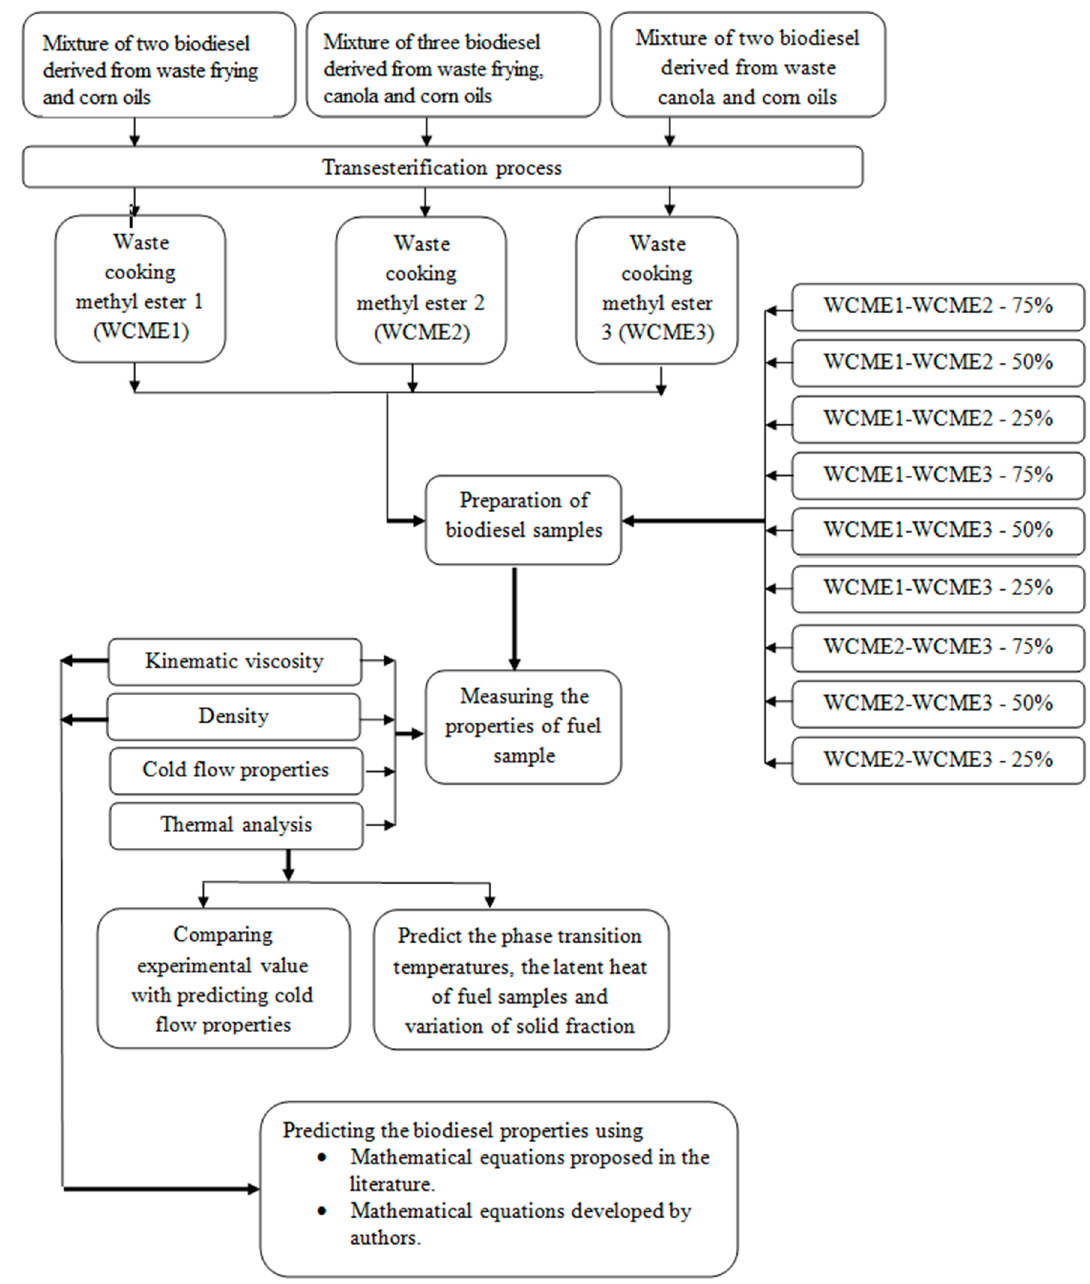
Figure 1. The flow of research works in this study.